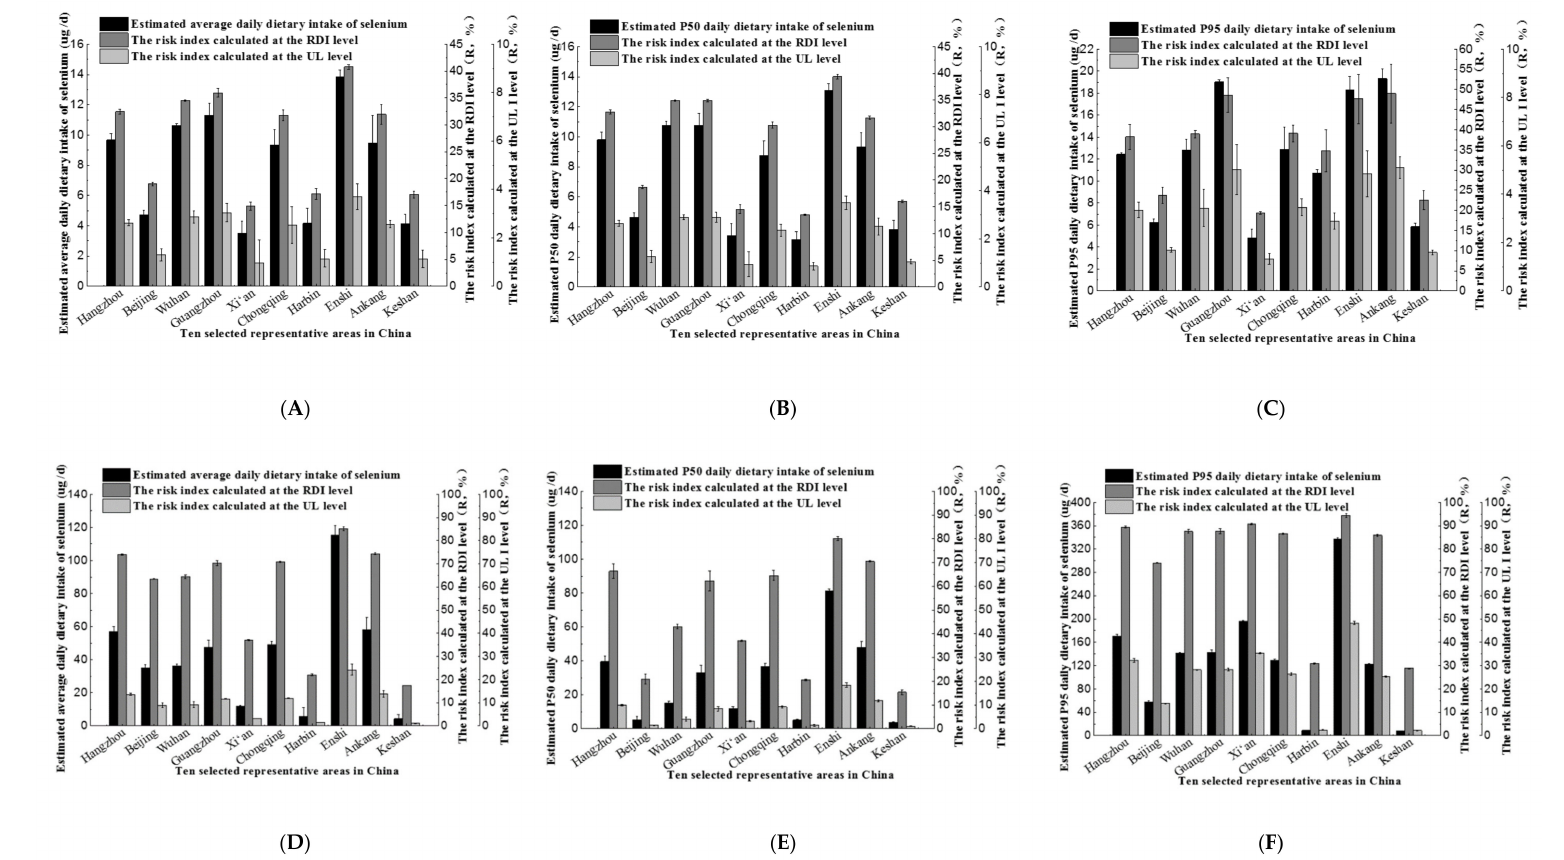
Figure 2. Dietary selenium intake and risk assessment of the population in di ff erent areas when they only eat common rice ( A – C ) or selenium-rich rice ( D – F ) (calculated by a standard person weighting 70 kg). When the risk index was calculated, the actual daily dietary selenium intake of the standard person was designated as 39.90 µ g / d, which was derived from the data of the “national dietary nutrition survey” of the Chinese nutrition society in 2012. The recommended intake dose (RDI) (recommended daily intake) was designated as 60 µ g / d and UL (tolerable upper intake level) as 400 µ g / d stipulated by the Chinese nutrition